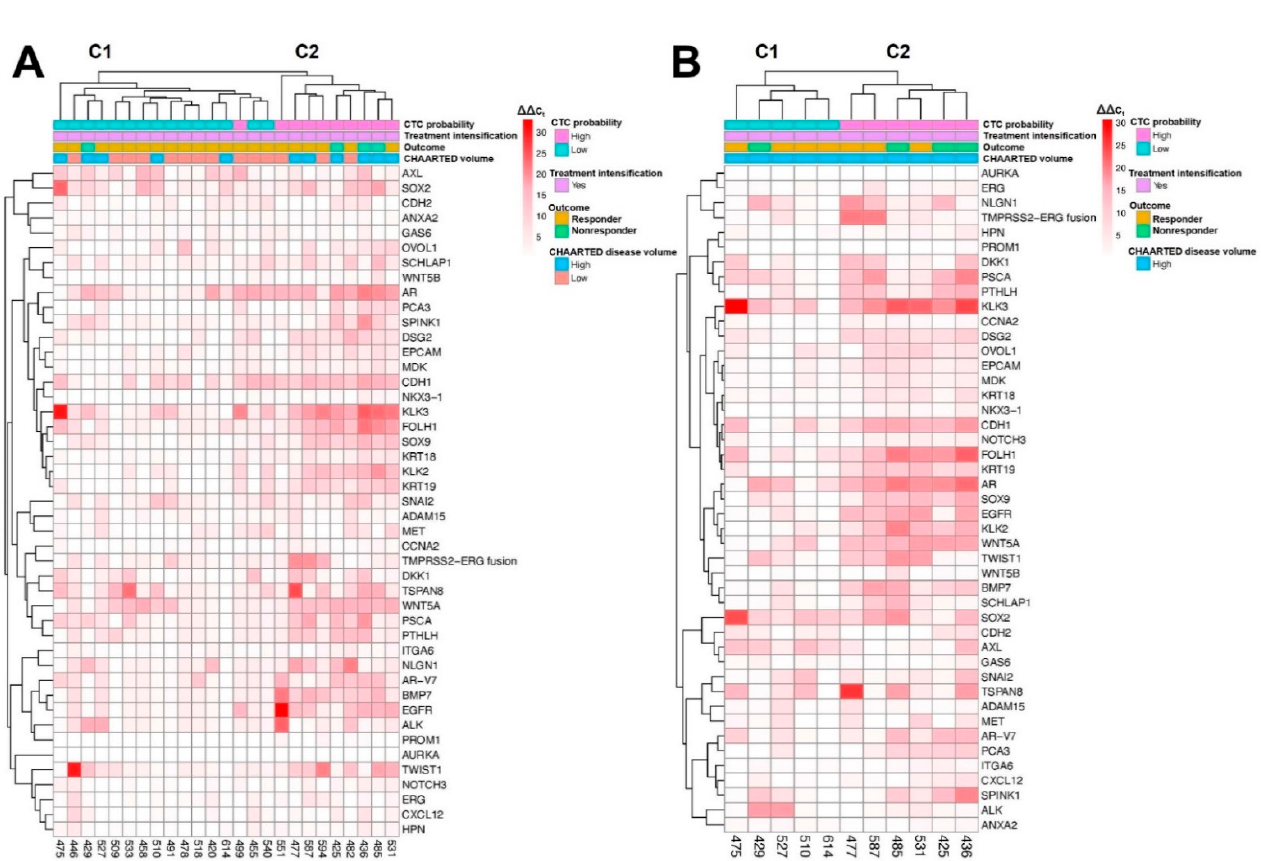
Figure 4. Unsupervised clustering of all patients ( A ) and HV patients ( B ) receiving treatment intensification within 3 months of initiating ADT. Patient characteristics, including treatment intensification and CHAARTED volume, and patient outcomes (responder/nonresponder) are annotated above the heatmap, and deidentified patient ID numbers and interrogated genes are annotated on the bottom and right of the heatmap, respectively.